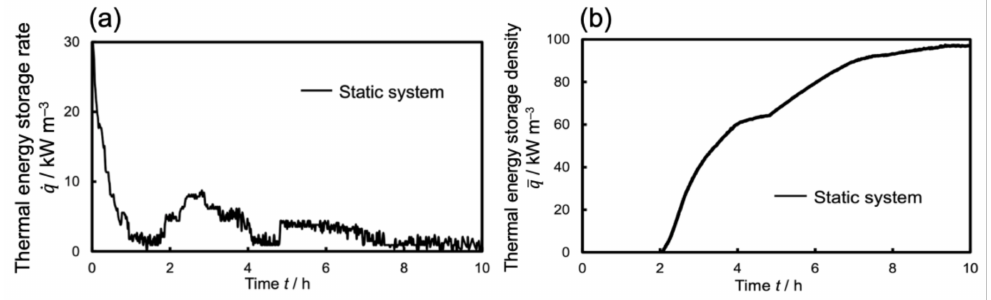
Figure 5. Time evolution of thermal energy storage rate and density in static system. ( a , b ) depict the thermal energy storage rate and density,